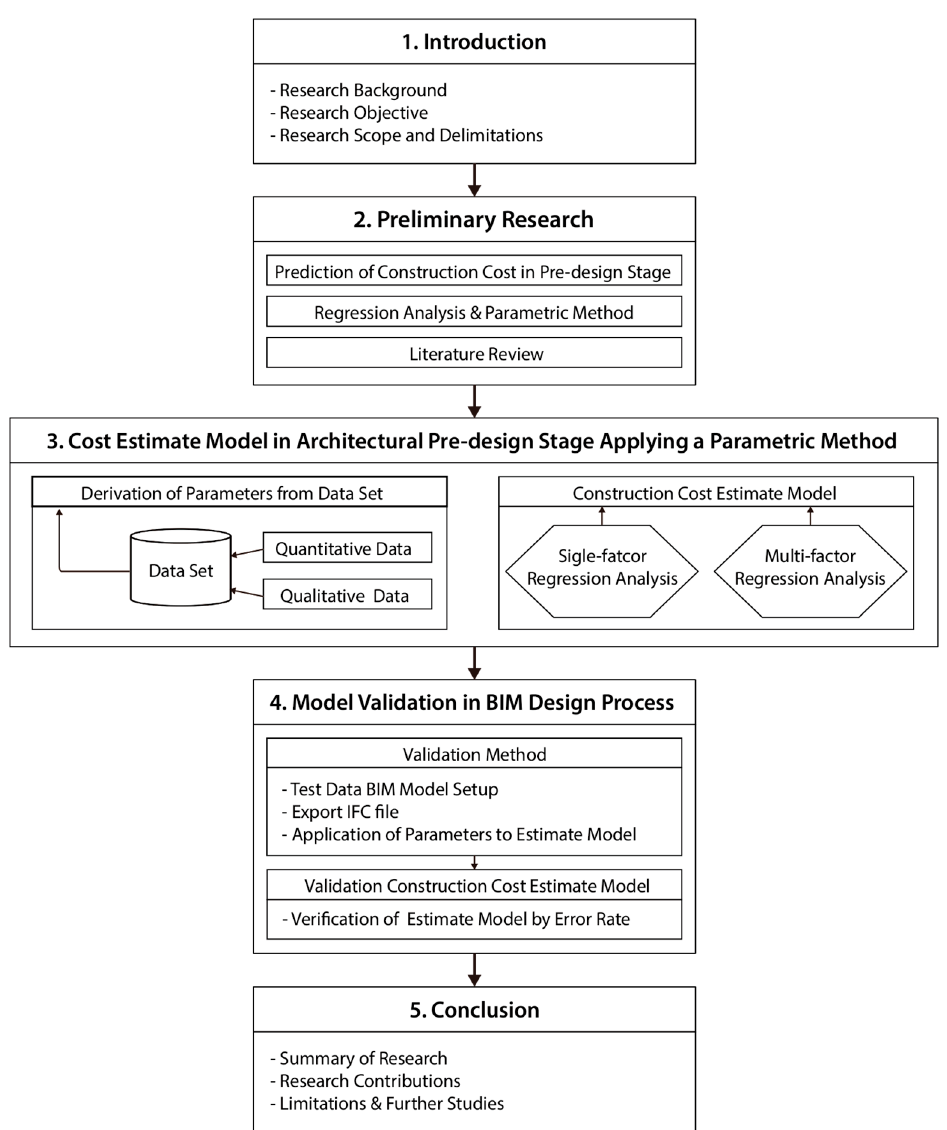
Figure 1. Research process flow.